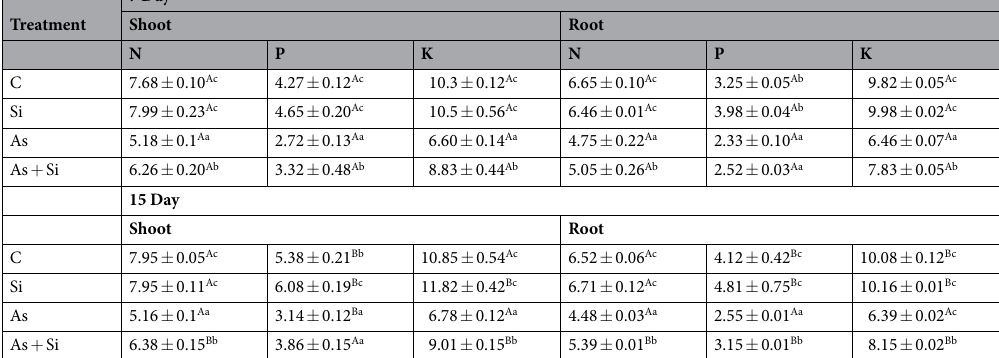
Nitrogen (N), phosphorus (P) and potassium (K) are considered as primary macronutrient, necessary for growth and development of rice plant. Analysis in the present study revealed that N, P and K content after As (III) treatment decreased at both exposure periods (7 and 15 d), in shoots and roots (Table 3), however, longer expo- sure (15 d) showed recovery in shoots P and K content (15% P and 2% K as compared to 7d). Application of As (III) + Si, increased NPK content in both shoots and roots of rice at both exposure periods, as compared to As (III) alone (a recovery of 2% N, 16% P and 9% K in shoots, 7% N, 25% P and 4% K in roots was observed at 15 d, compared to 7 d). Additionally, four micronutrients (Mn, Fe, Cu, and Zn) were also decreased signifi- cantly ( P < 0.05) in rice plant treated with As (III) alone, in shoots and roots at 7 and 15 d (Table 4). Overall, results indicated that macro-micronutrient content decreased in both shoot and root when plant were treated with As (III) only. On the other hand, co-application of Si along with As (III) , could overcome the deficiency of nutrients caused due to toxicity of As (III) .